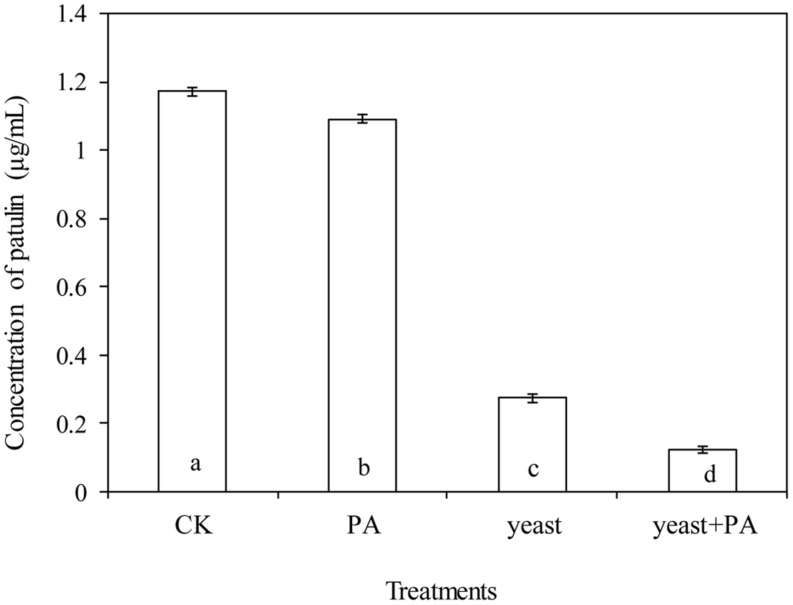
Effects of R. mucilaginosa in combination with PA on the patulin content produced by P. expansum in apples. Fruit treatments are as follows: CK = sterile distilled water, PA = 4 μmol/mL PA, yeast = R. mucilaginosa (1 × 108 CFU/mL), yeast + PA = R. mucilaginosa (1 × 108 CFU/mL) + 4 μmol/mL PA. Bars represent standard deviations. Different letters indicate significant differences (P < 0.05) according to the Duncan’s multiple range test.